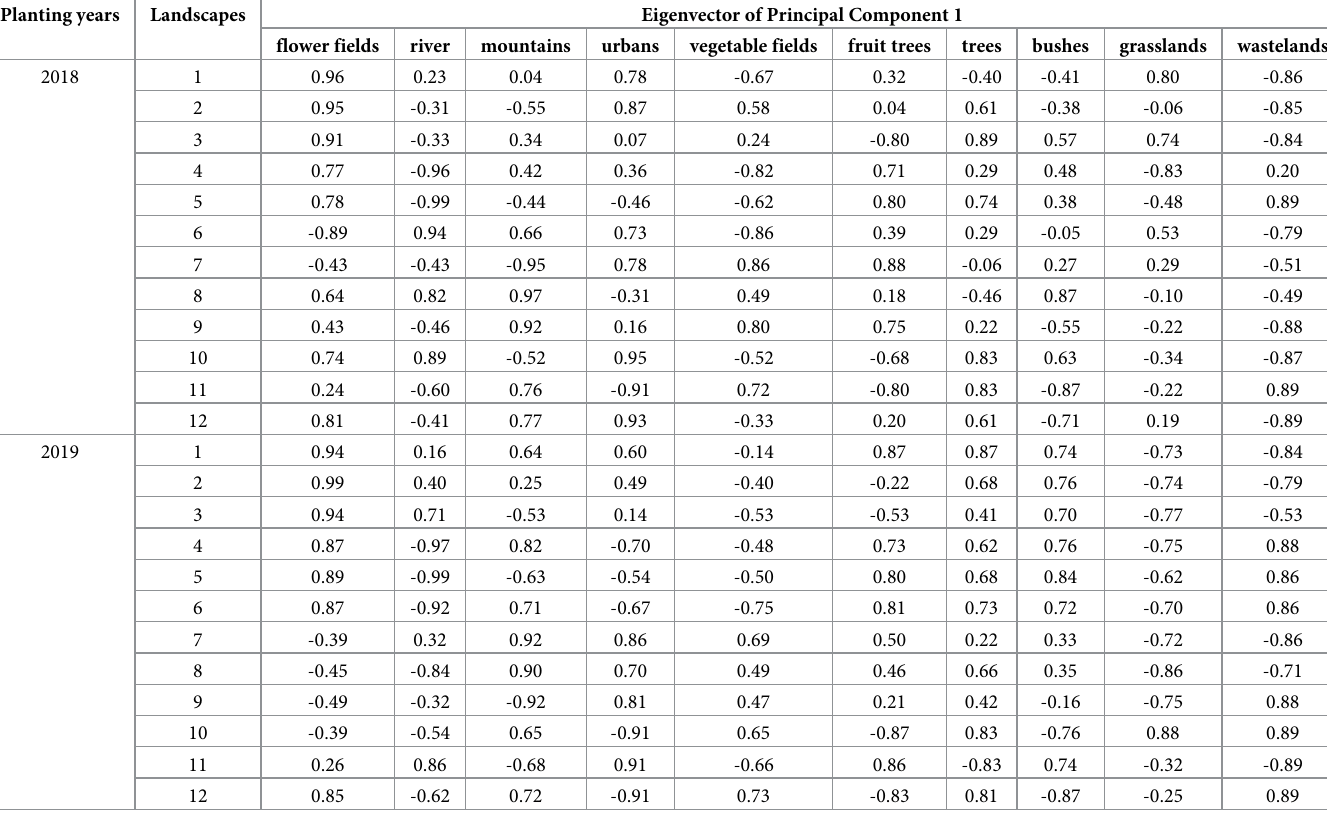
Table 1. Principal component loading diagrams examining the landscape variables at four landscape types. Planting years